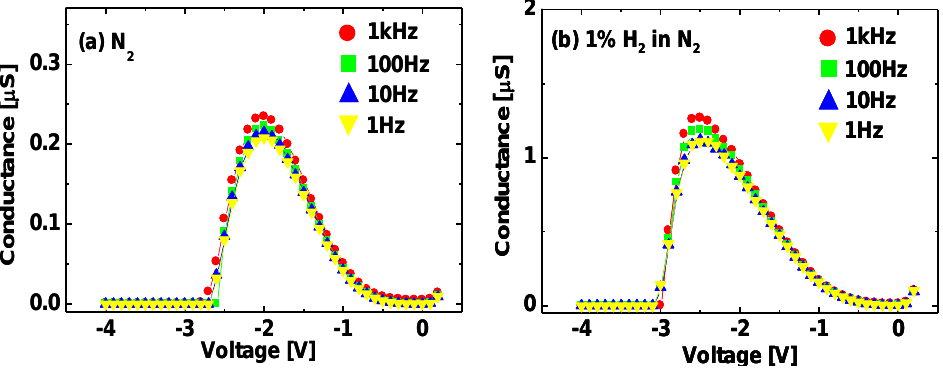
Room-temperature G-V characteristics at various frequencies of